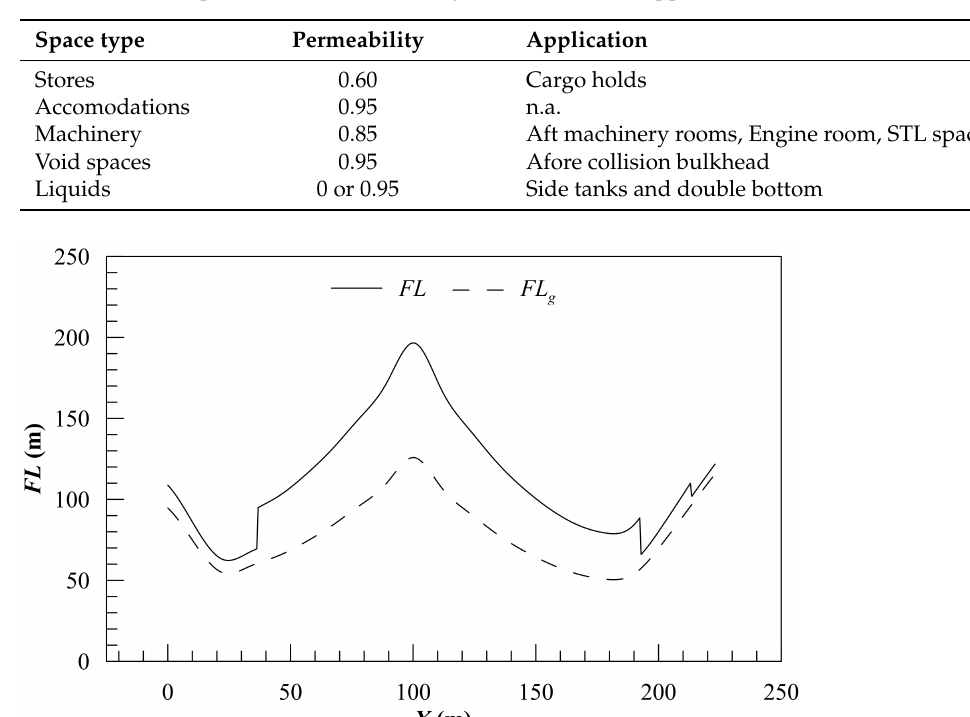
Table 3. Standard permeabilities assumed by SOLAS and their application.